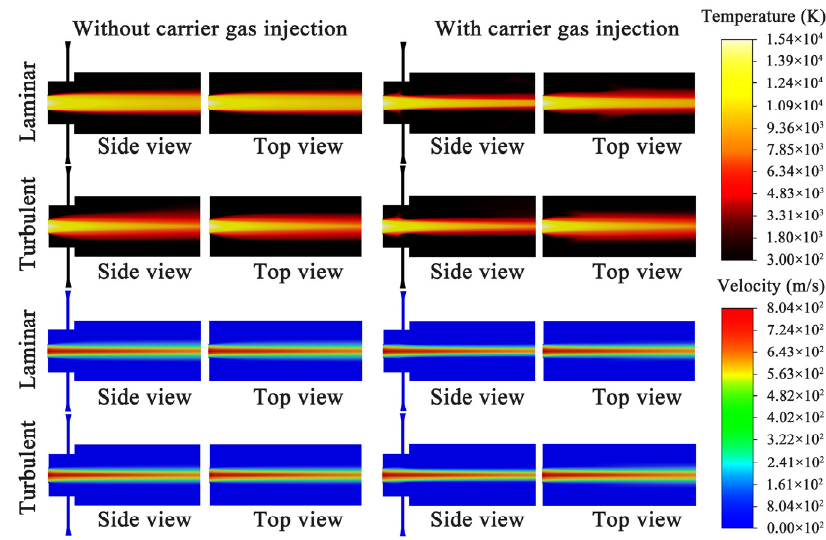
Figure 7. Calculated plasma jet temperature and velocity distribution.